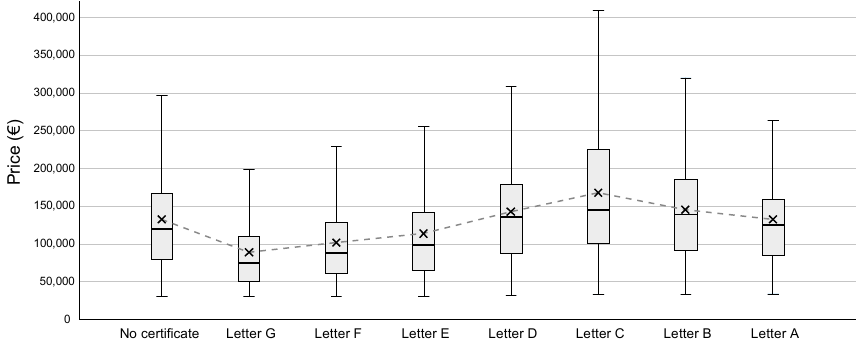
Figure 6. Graph representing the mean asking price and box plot, based on energy qualification.